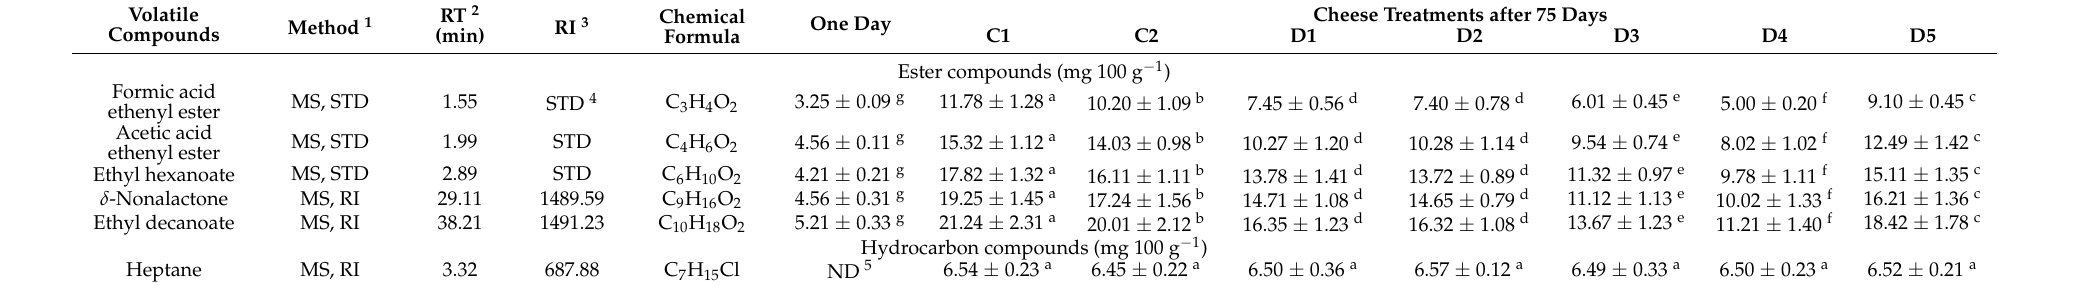
Table 5. Volatile ester and hydrocarbon compounds identified in cheese packaged under modified atmospheres (means ±